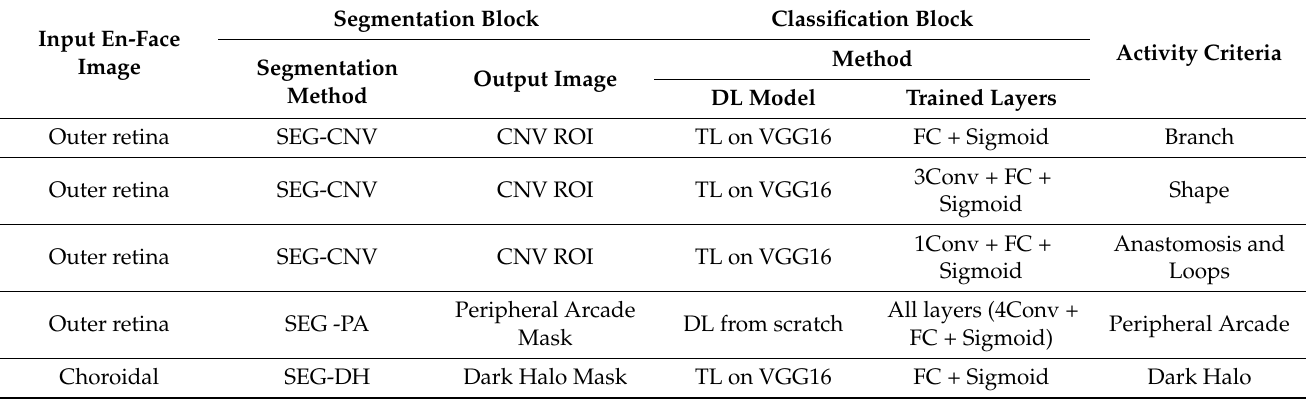
Table 2. Description of CNV lesion classification